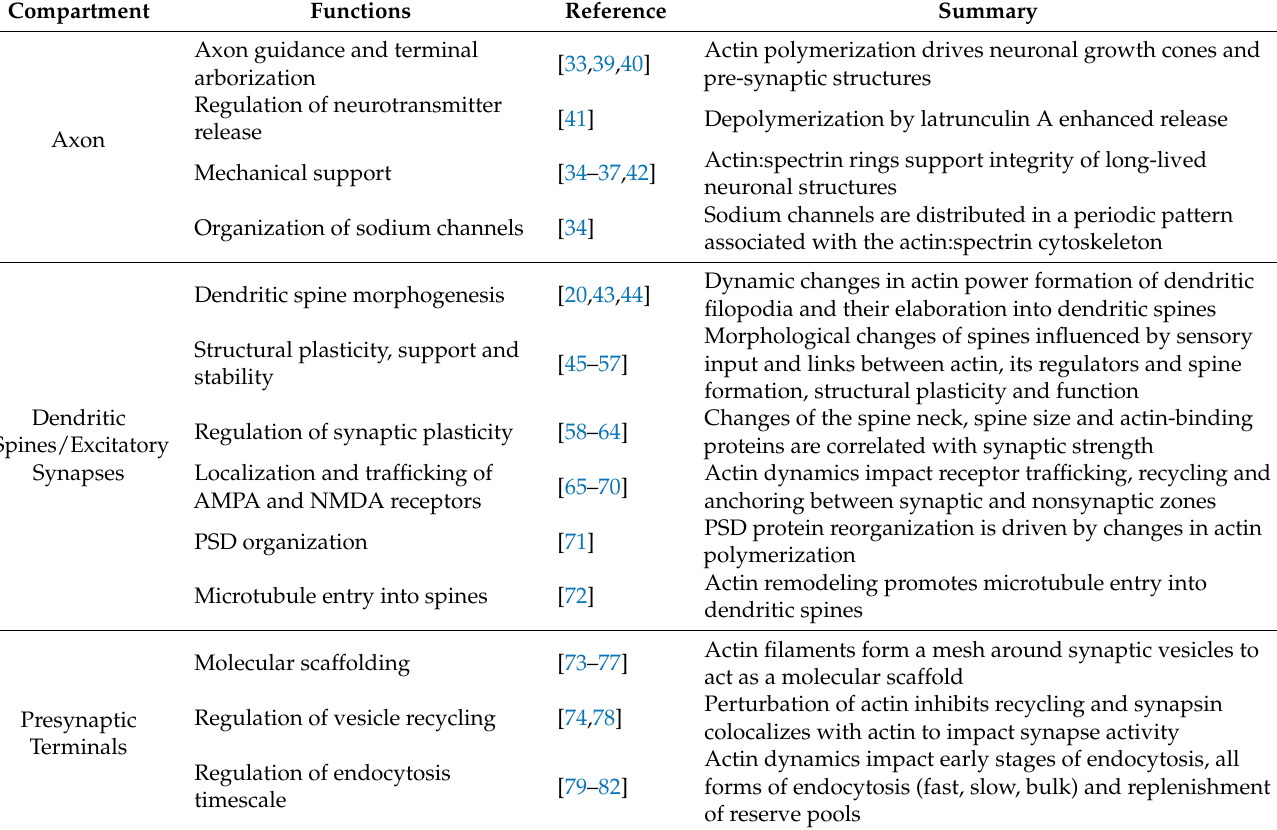
Table 2. Summary of actin’s role in neuronal